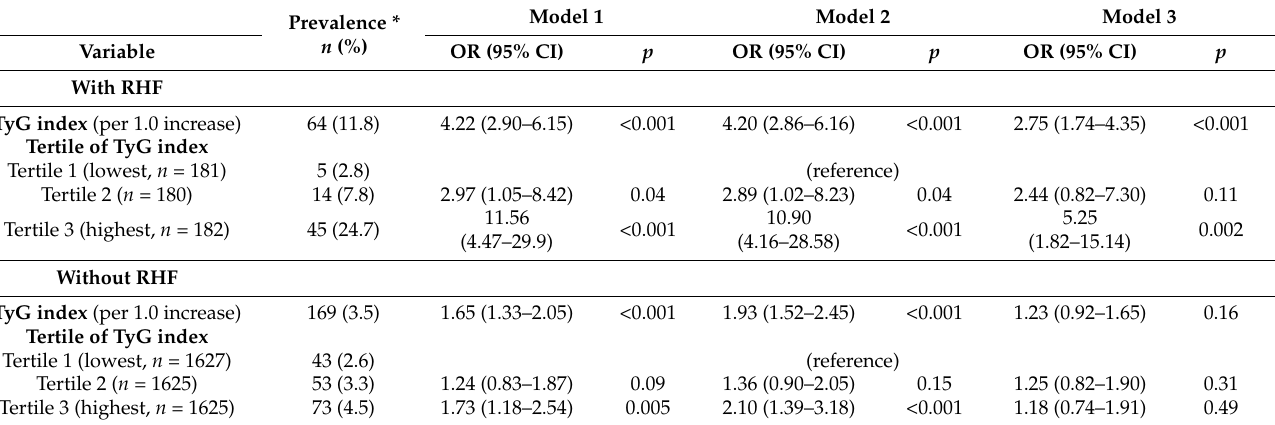
Table 4. Association between albuminuria and TyG index with or without RHF.